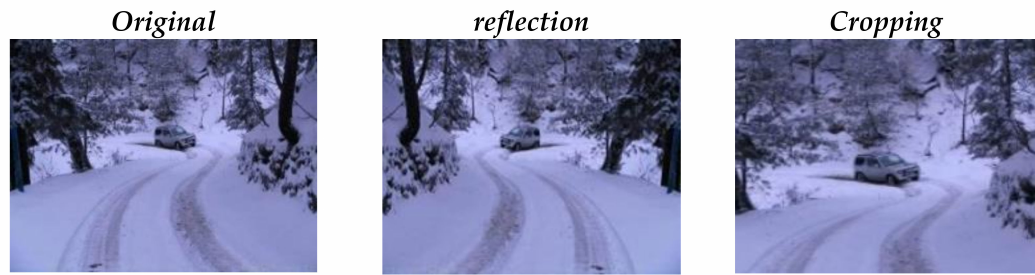
Figure 4. Sample images resulted in form data augmentation